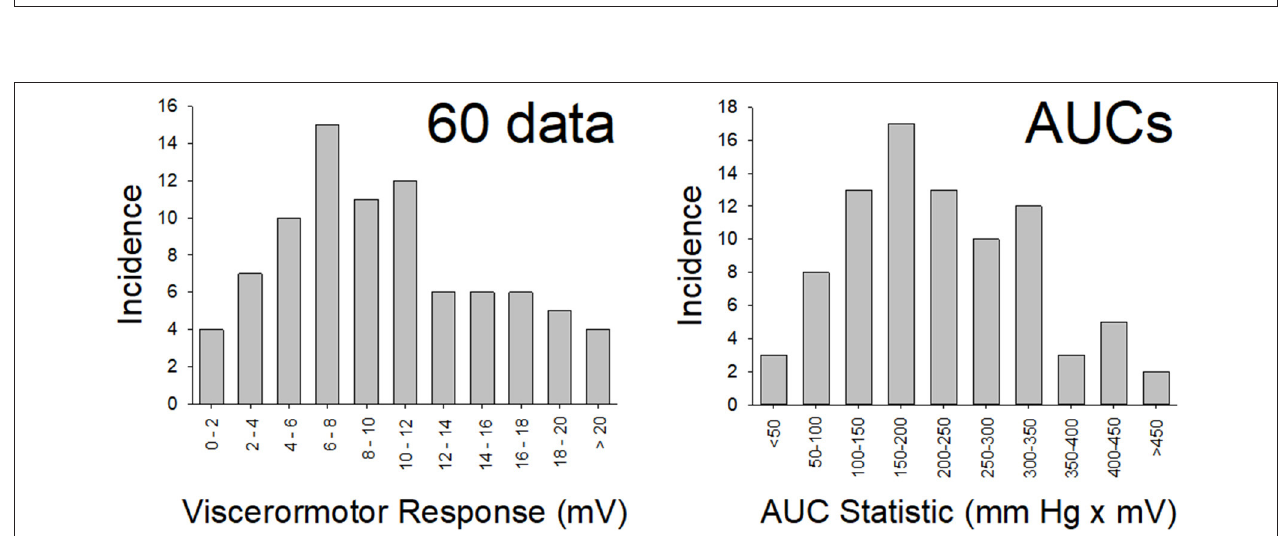
FIGURE 2 | Normal Distribution of Data. Distribution of data from the “control” ( n = 86) rats in the present study for vigor of visceromotor responses to a 60mm Hg, 20s UBD (disrete stiumulus data; left panel) and for the Area-Under-the-Curve measures (overall responses; right panel) to graded UBD. These rats did not experience NBI as pups or any second insult as adults. Both data sets met tests of normality (more explanation and statistics in main text).